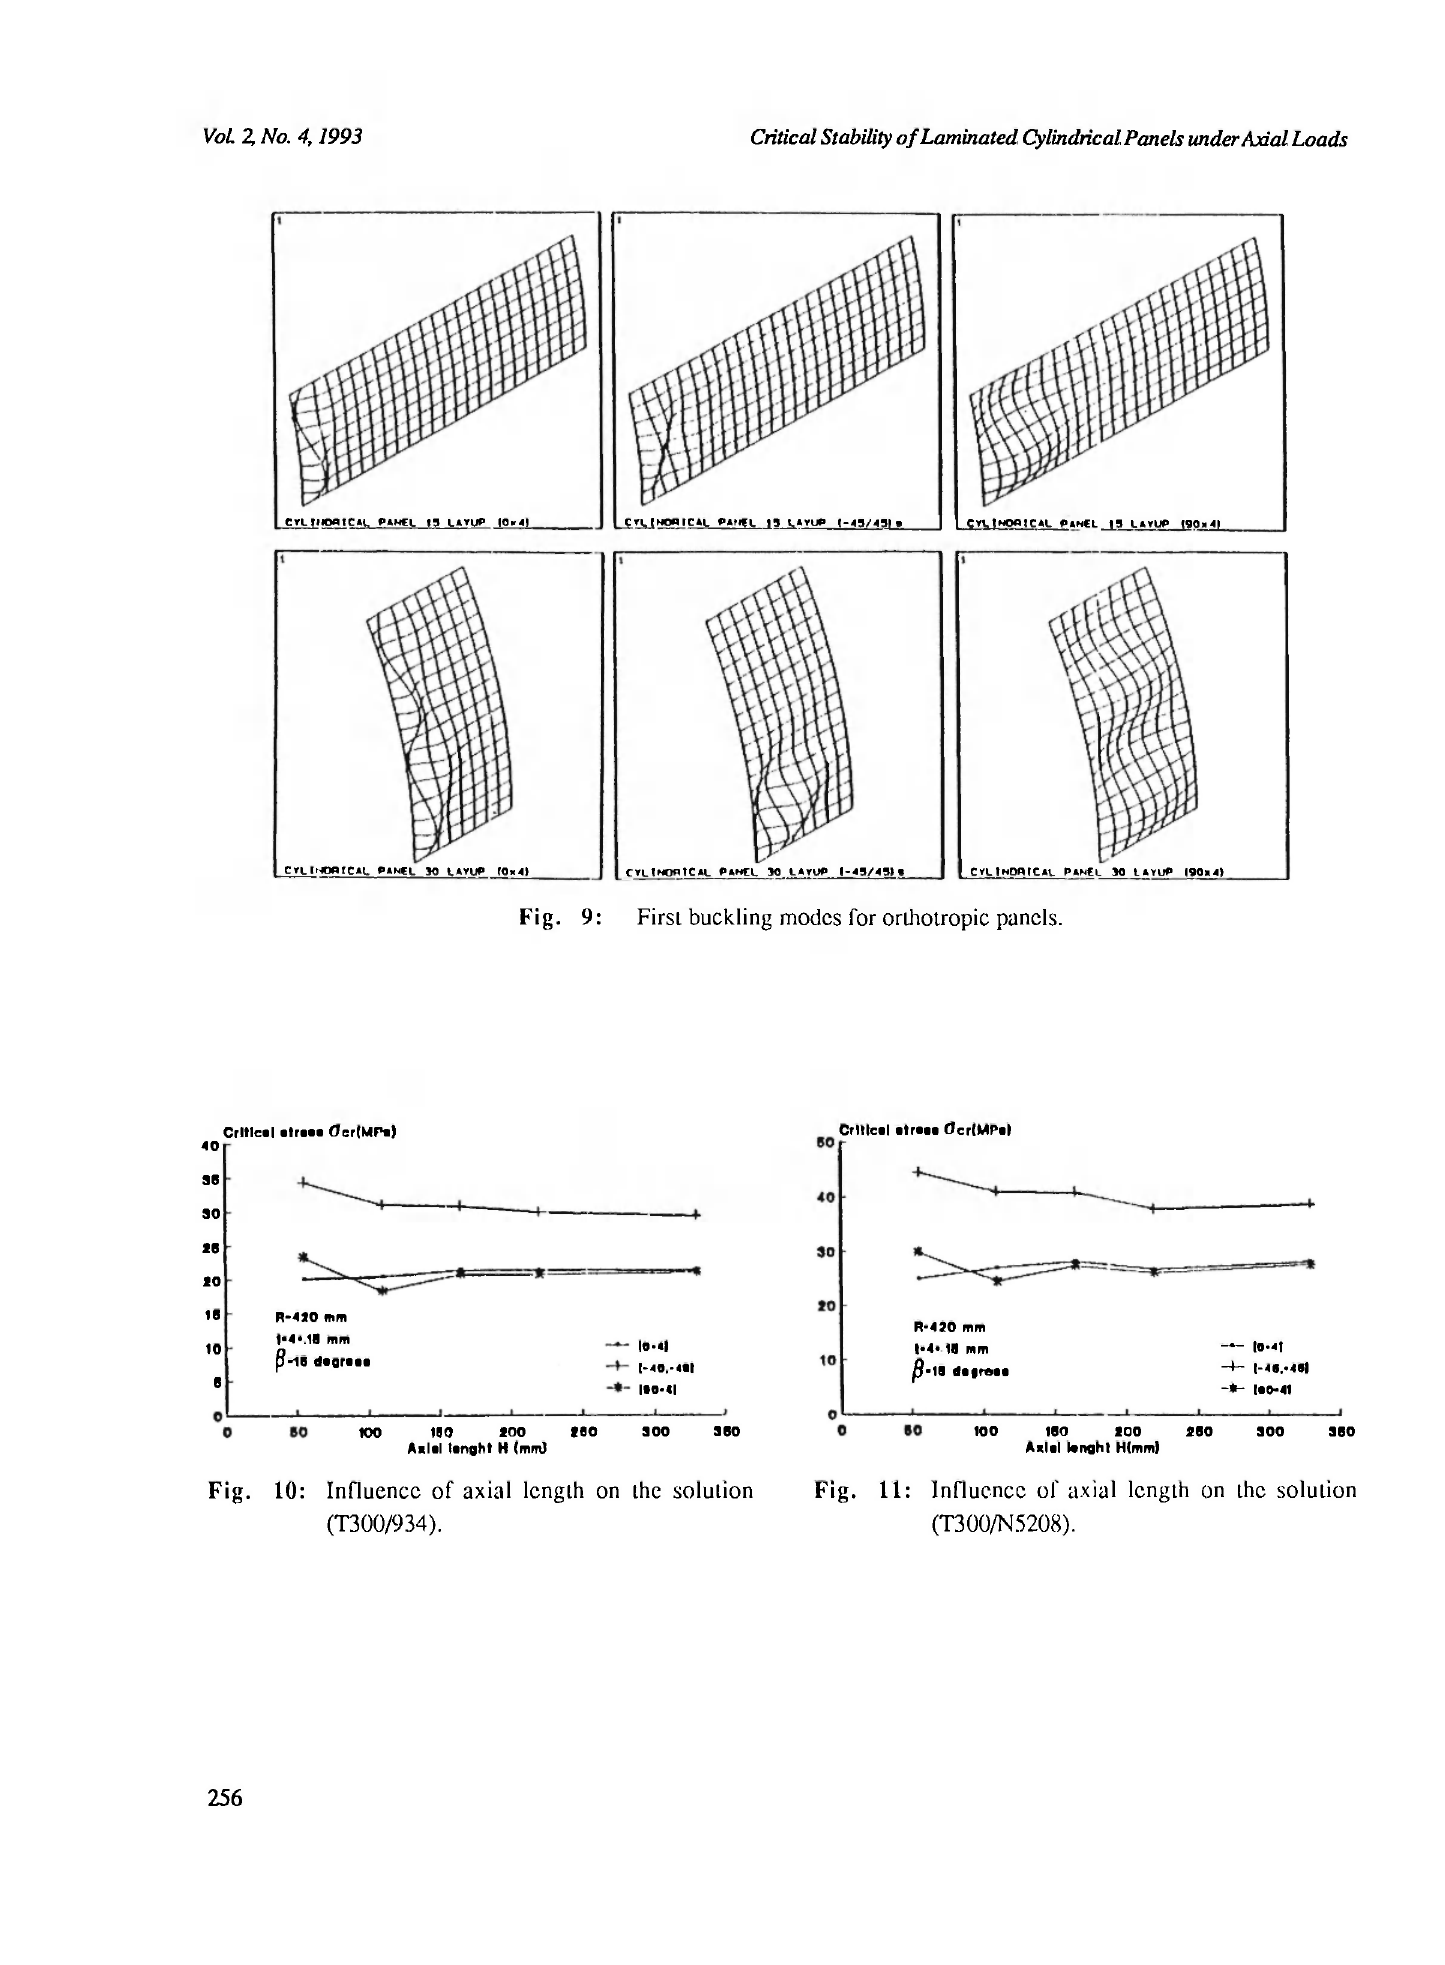
10: Influence of axial length on the solution (T300/934).